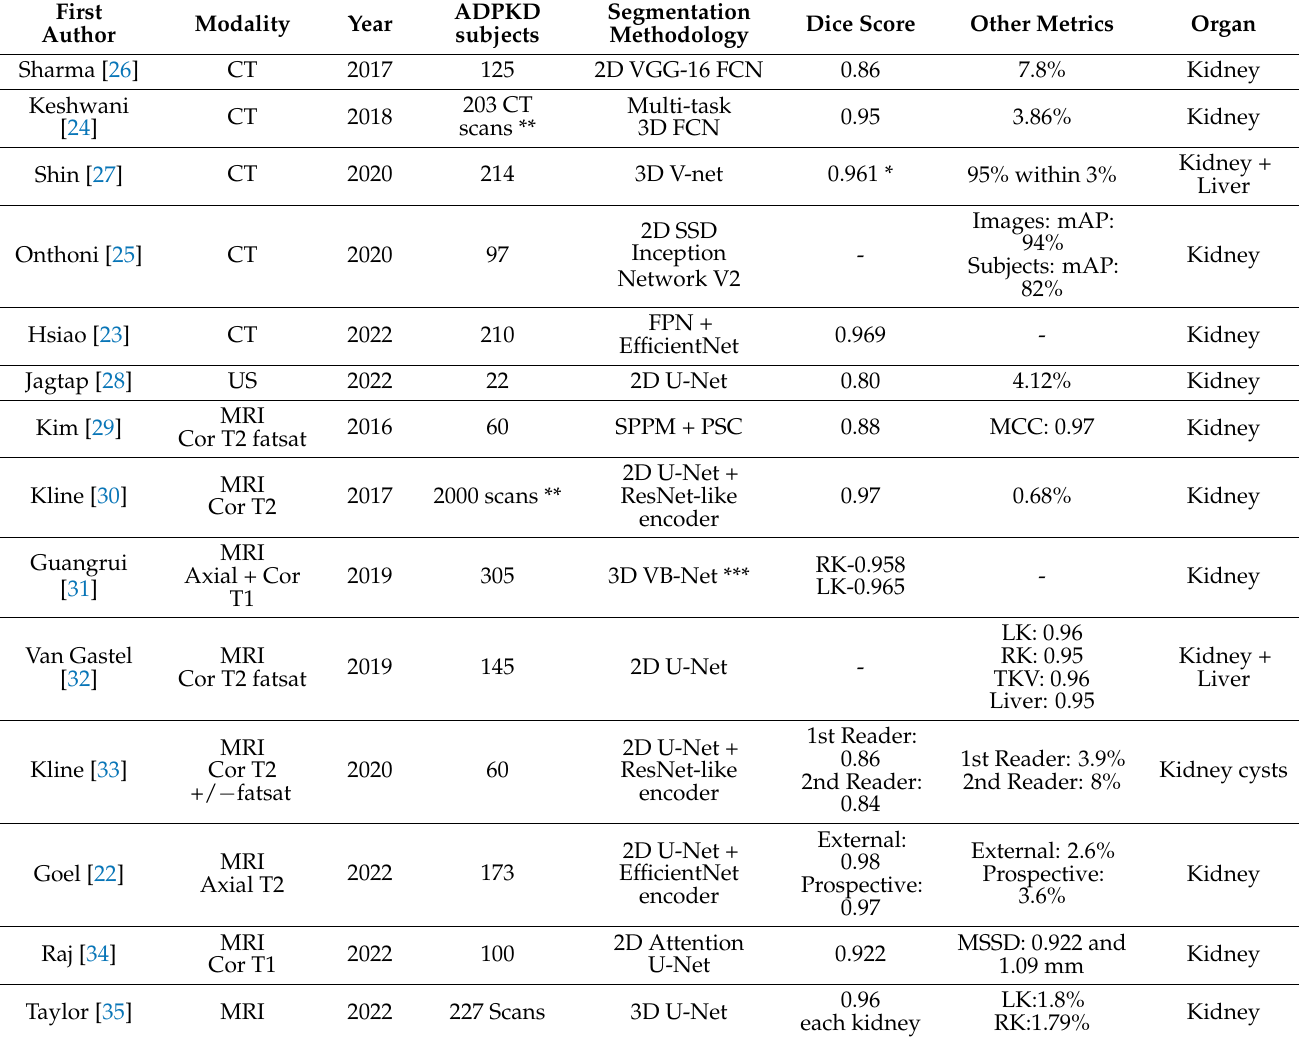
Table 1. Literature on deep learning methods for organ volume measurements in